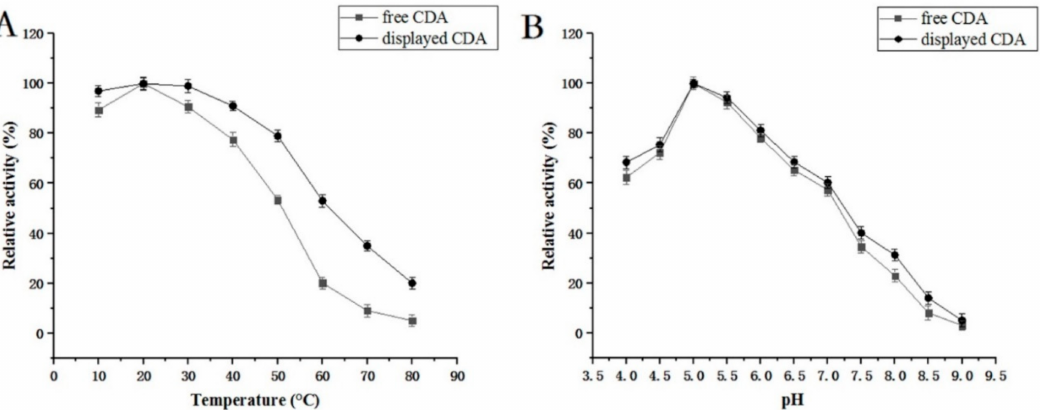
Figure 6. ( A ) Temperature optimization for CDA enzyme activity. Enzyme activity at 30 ◦ C was set to 100%; ( B ) pH optimization for CDA enzyme activity. Enzyme activity at pH 5.0 was set to